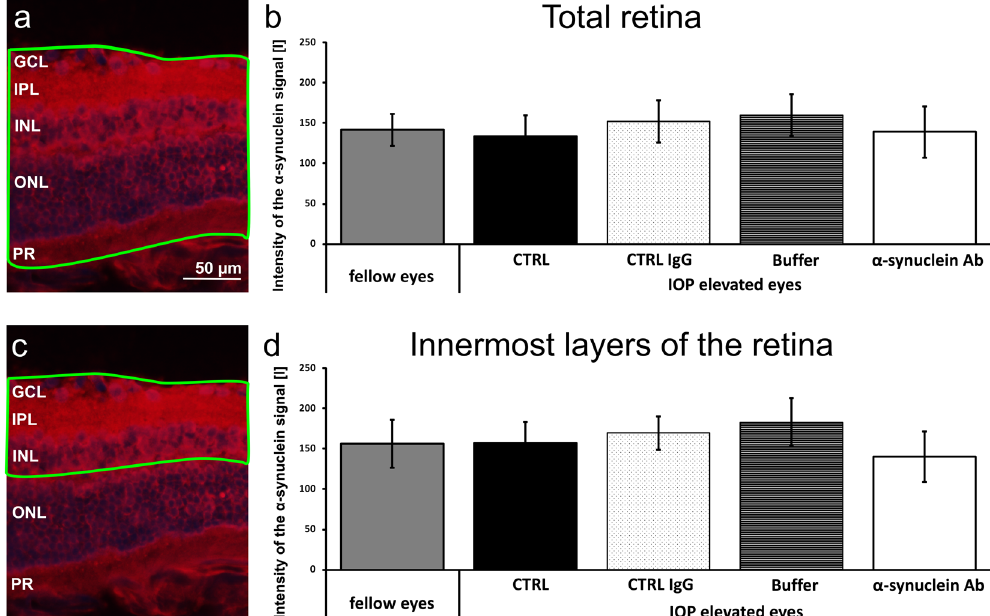
Figure 6. Expression levels of α -synuclein protein in retinal cross sections. The intensity level of α -synuclein protein signal was compared in the total retina after immunohistochemistry on retinal cross sections using rabbit α -synuclein primary Ab and a goat anti-rabbit IgG (H + L) Cy3 secondary Ab. ( a ) The green box indicates the region which is included in the analysis. ( b ) No differences were observed for α -synuclein signal intensity [I] between the experimental groups. ( c ) The innermost layers of the retina includes the GCL, IPL and INL, indicated by the green box. ( d ) No differences were observed for α -synuclein signal intensity between the experimental groups. Abbreviations: GCL: ganglion cell layer, IPL: inner plexiform layer, INL: inner nuclear layer, ONL: outer nuclear layer, PR: